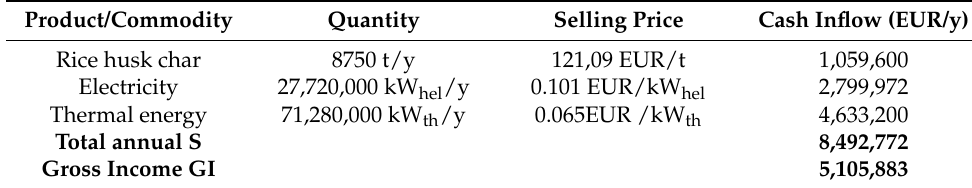
Table 12. Cash inflows (S).